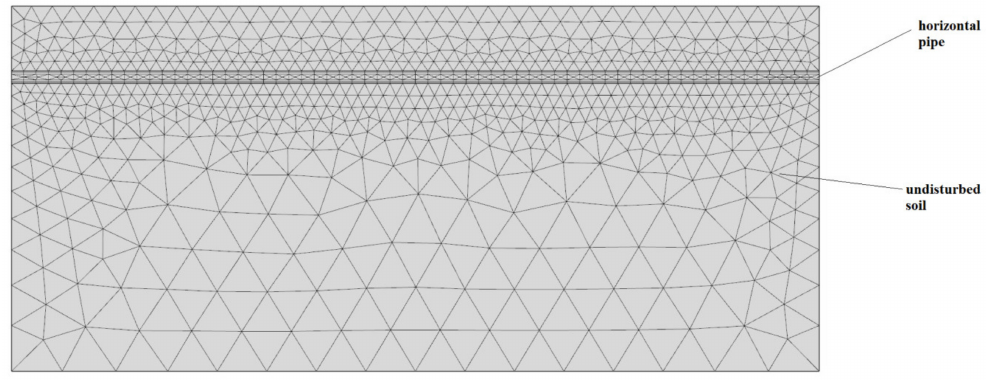
Figure 3. Computational mesh domain of the investigation on a single buried pipe of the